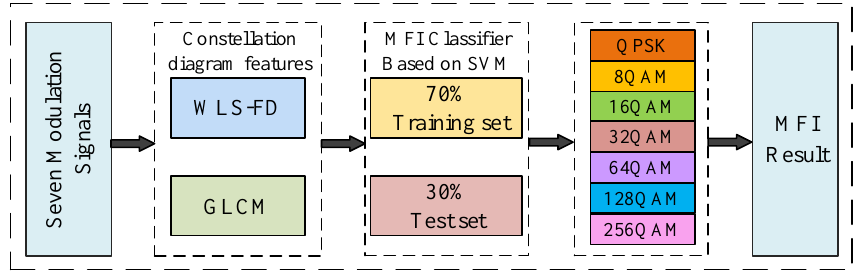
Figure 1. The architecture of the MFI scheme.